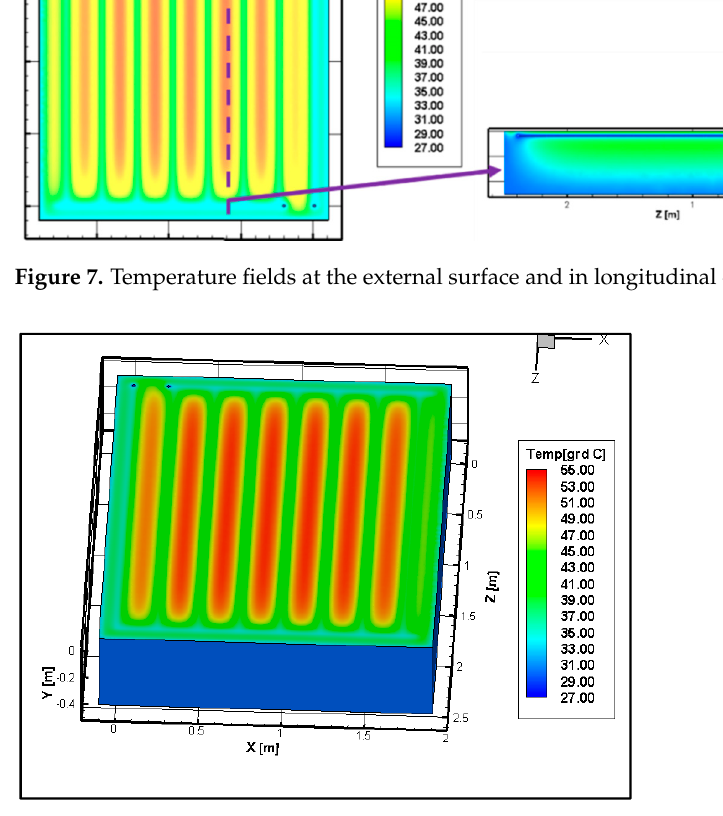
Figure 8. Surface temperature fields, isometric views.